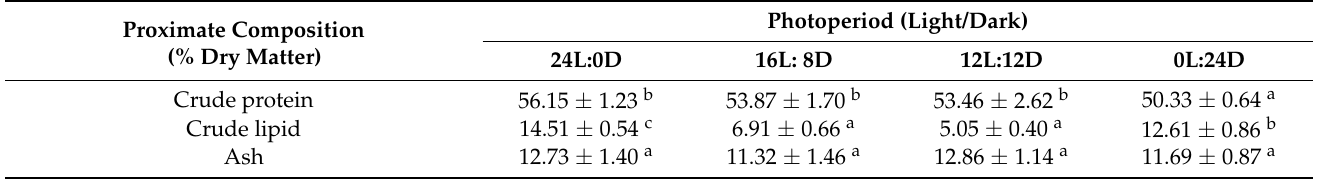
Different superscript letters within each row indicate statistically significant differences at p < 0.05. Table 4. Effect of different photoperiods on fatty-acid profile of B. orientalis at the end of the trial (mean ± SD, n = 3). Fatty Acids Profile Photoperiod (Light: Dark) (% area of total fatty acids)